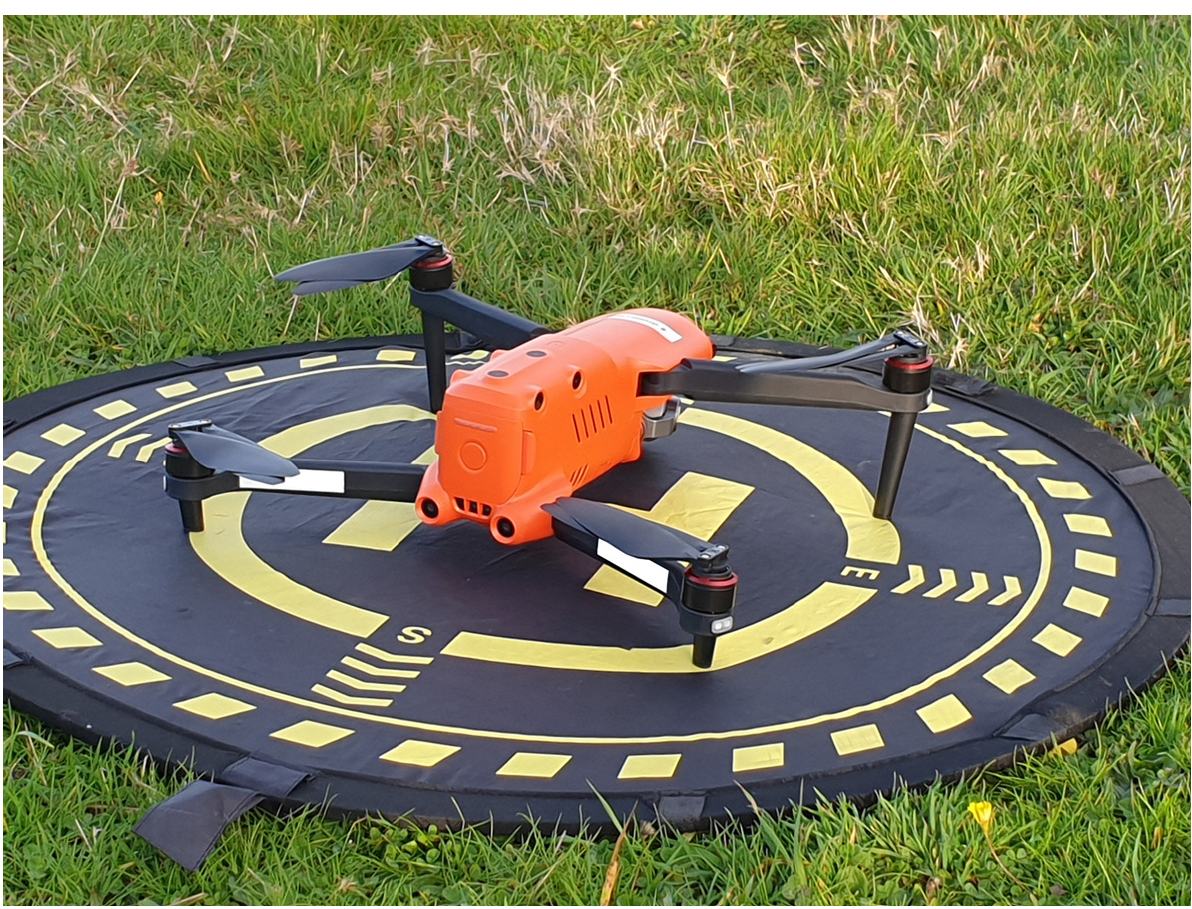
Figure 3. Autel Robotics EVO Pro